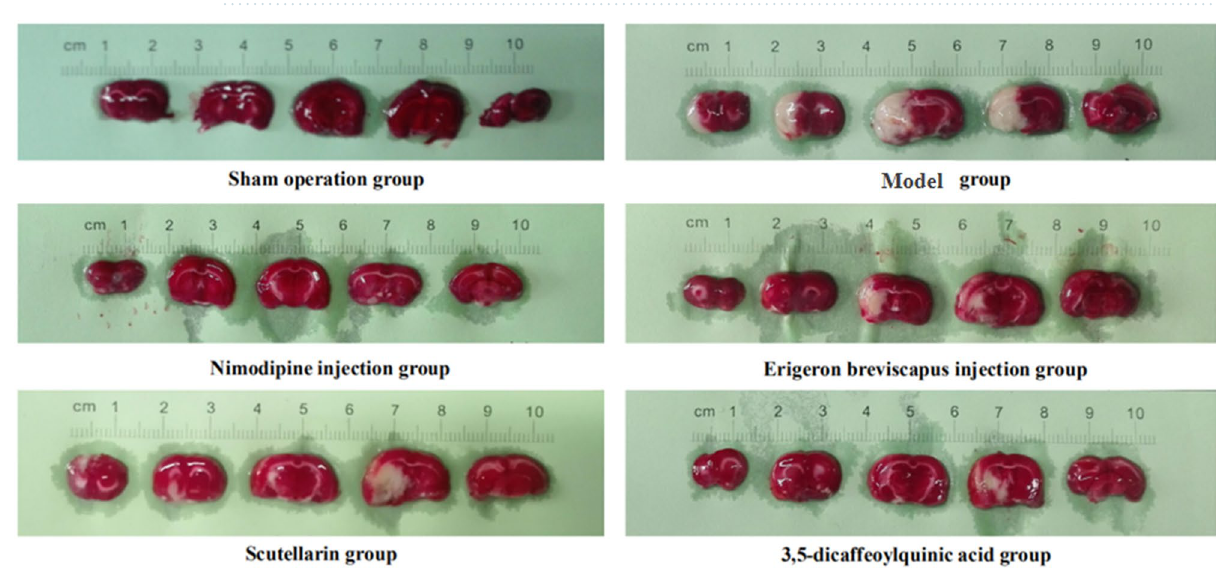
Figure 3. Changes of the cerebral infarction rate in rats. The values are presented as mean ± SD. (n = 6), * compared with the model group, * P < 0.05 and ** P < 0.01.